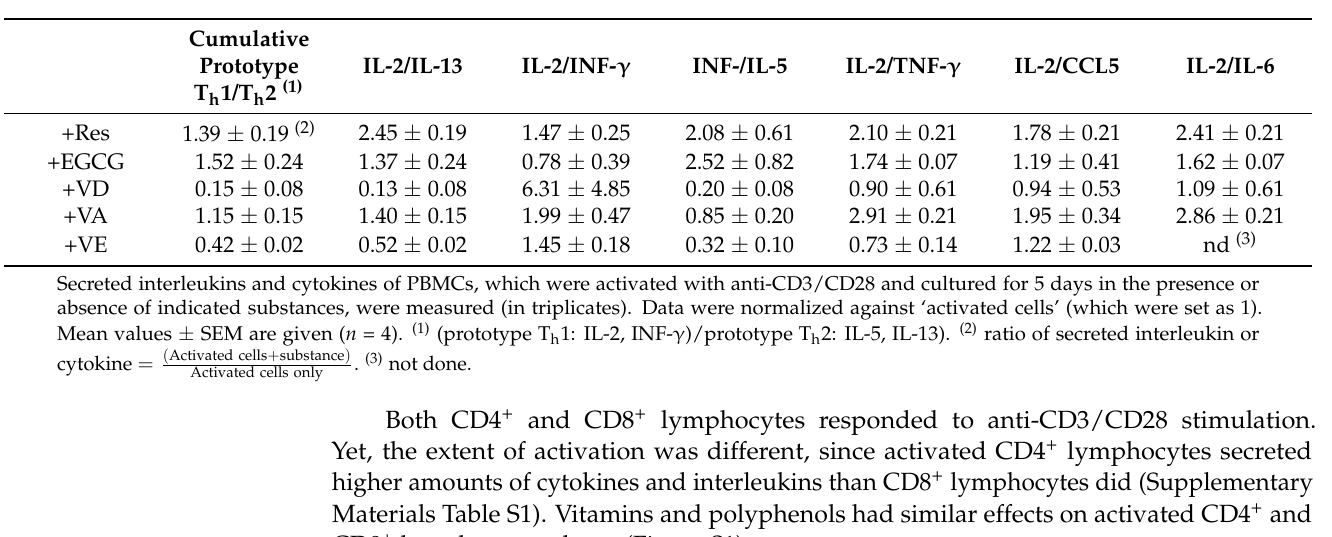
Table 2. Substances induced shift in the T h 1 and T h 2 prototype interleukin secretion.